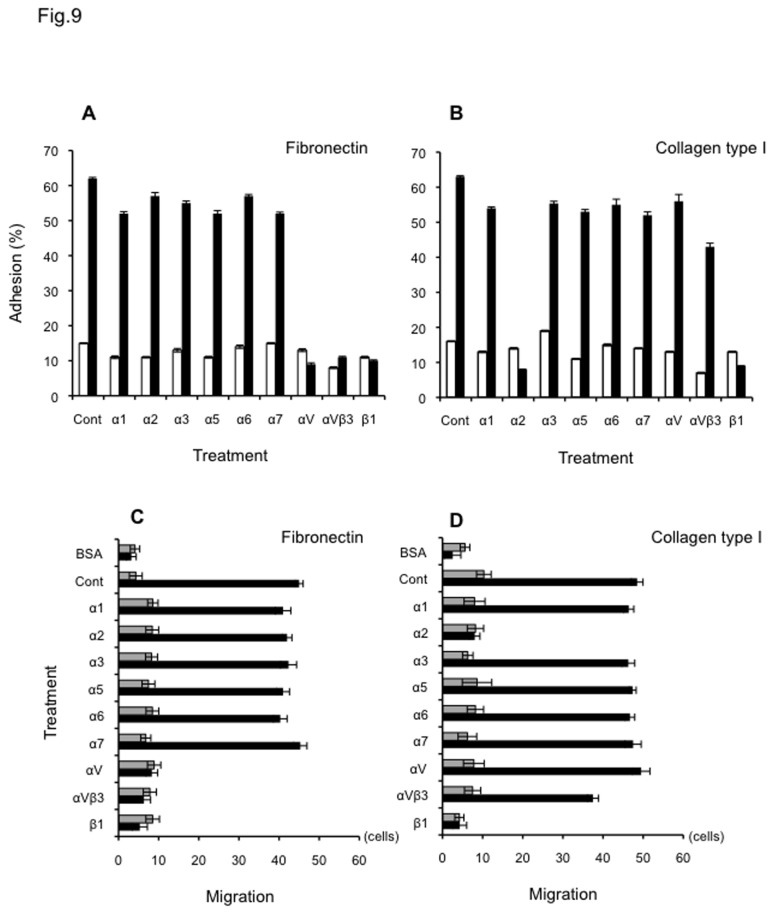
Adhesion and motility of differentiated cells on collagen type-I and fibronectin.(A, B) The adhesion of differentiated (black bars) and undifferentiated (white bars) iPS cells to a substratum of either Fn (5 μg/ml; A) or Col-I (1 μg/ml; B) was assayed in the presence of the indicated anti-integrin antibodies. Data are the number of adherent cells, expressed as a percentage of the total number of cells. Bars indicate the standard deviation. (C, D) Similar experiments were used to investigate motility. The migration of differentiated (black bars) or undifferentiated cells (grey bars) through Transwell inserts coated with Fn (5 μg/ml; C) or Col-I (1 μg/ml; D) was assayed in the presence of the indicated anti-integrin antibodies. Cells were added to the upper chamber and incubated for 3 h. Motility was estimated by counting the number of cells that had migrated to the undersides of the membranes. Data presented are the mean ± SD of at least 10 random microscopic fields.